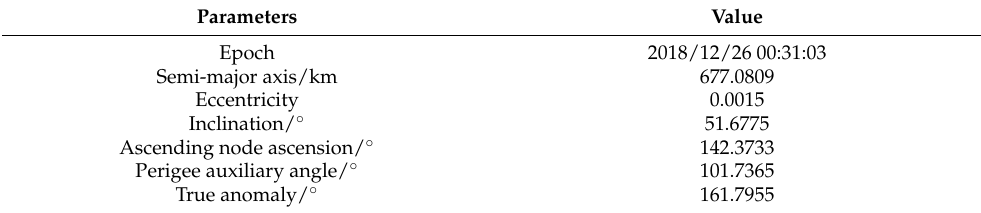
Table 5. The estimated orbit parameters of the International Space Station (ISS).